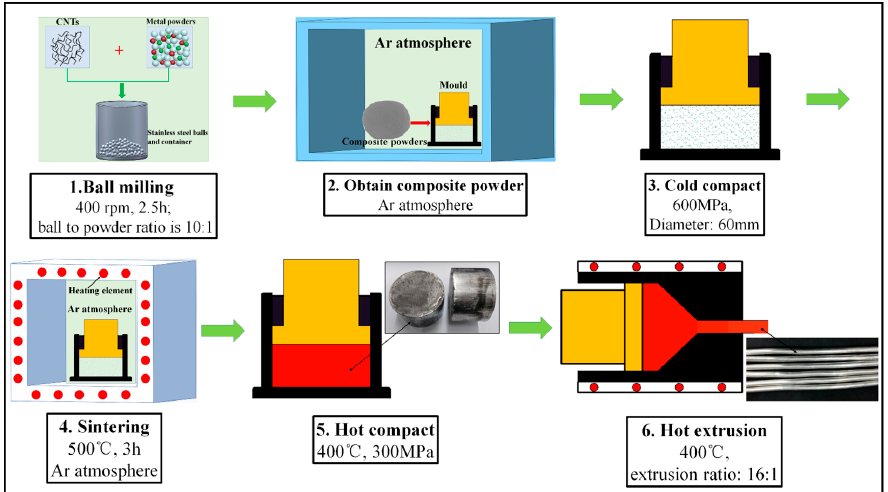
Figure 1. Sketch diagram of the fabrication process.